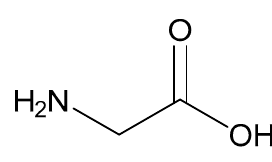
Figure 11. Structure of glycine.